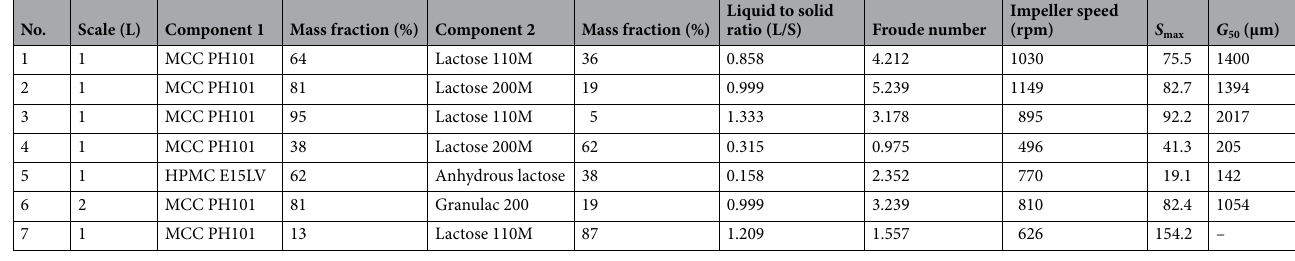
Table 2. The results of laboratory granulation experiments for model improvement.